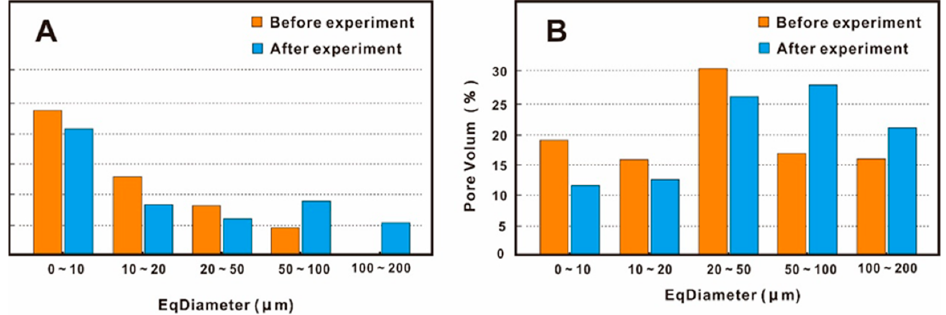
Figure 10. The relationship between the equivalent diameter and the percentage change of pore volume ( A ) sample A-130; ( B ) sample Q-148.